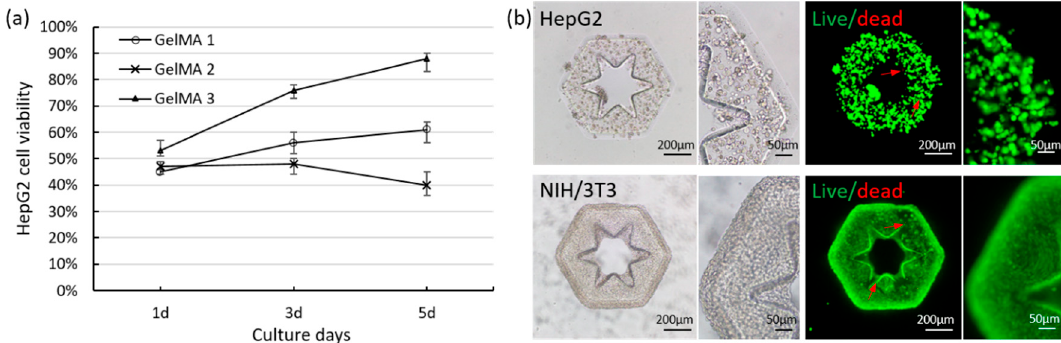
Figure 2. ( a ) The viability of HepG2 cells respectively encapsulated in GelMA 1, GelMA 2, and GelMA 3 during 5 days culture; ( b ) Live/dead staining of GelMA 3 micromodule encapsulating HepG2 cells and GelMA 3 micromodule encapsulating NIH/3T3 cells after culturing 10 days.